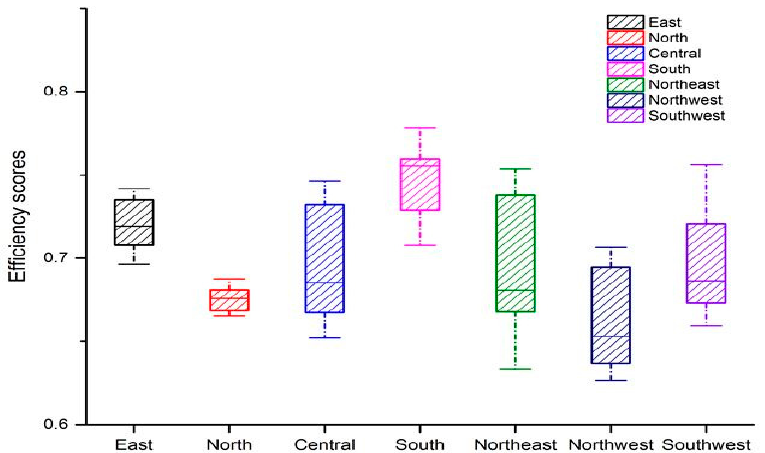
Figure 3. Changing trends of eco-efficiency in China’s seven regions from 2004 to 2016. East: Shanghai, Jiangsu, Zhejiang, Anhui, Fujian, Jiangxi, and Shandong; North: Beijing, Tianjin, Shanxi, Hebei, and Inner Mongolia; Central: Henan, Hubei, and Hunan; South: Guangdong, Guangxi, and Hainan; Northeast: Heilongjiang, Jilin, and Liaoning; Northwest: Shaanxi, Gansu, Qinghai, Ningxia, and Xinjiang; Southwest: Chongqing, Sichuan, Guizhou, and Yunnan.